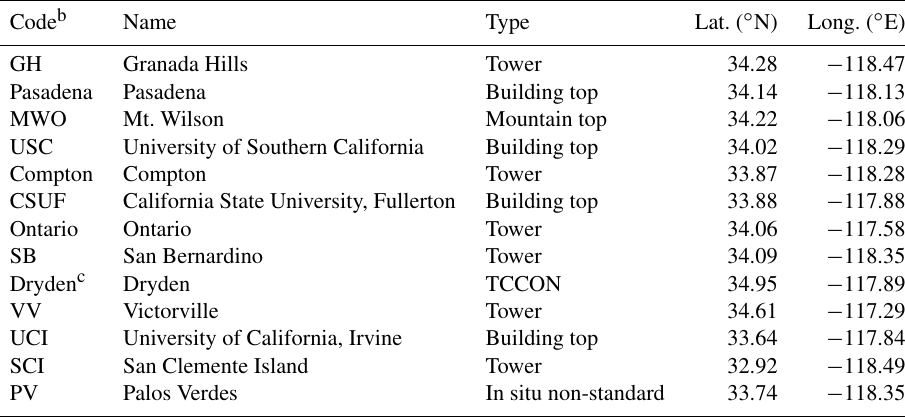
Table 6. Locations of the 2015-era GHG measurement sites in the model domain a